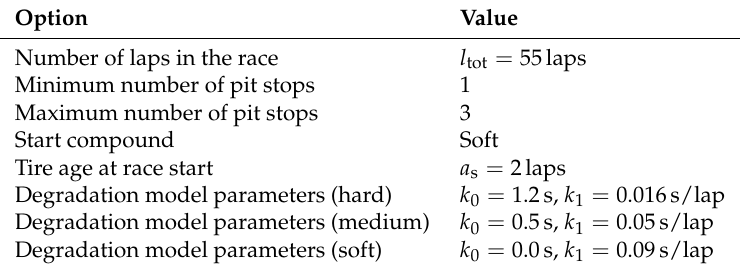
Table 8. Parameters of an example race used to optimize the basic race